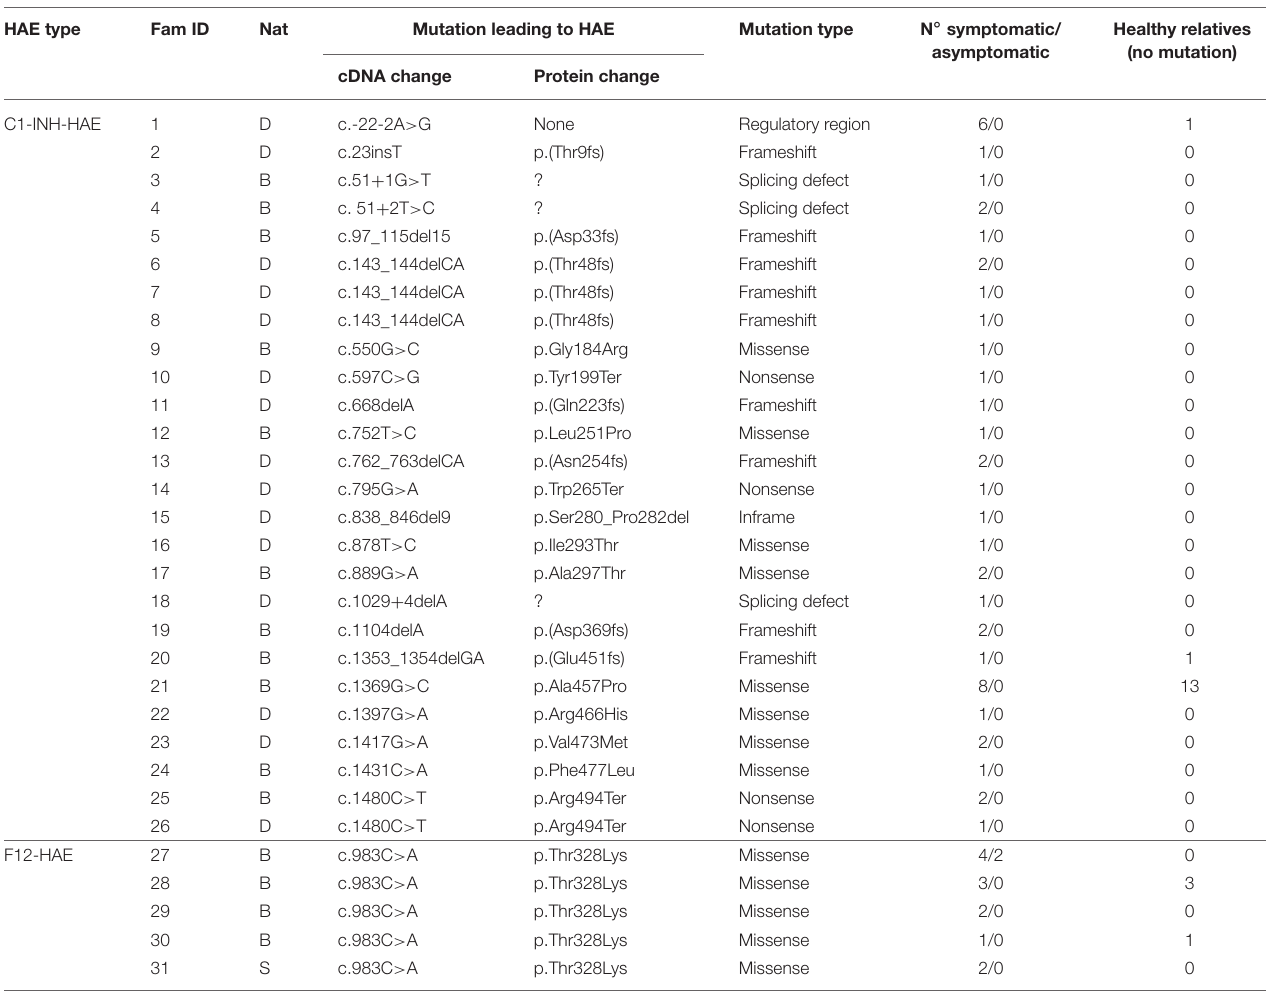
TABLE 1 | Families analyzed by